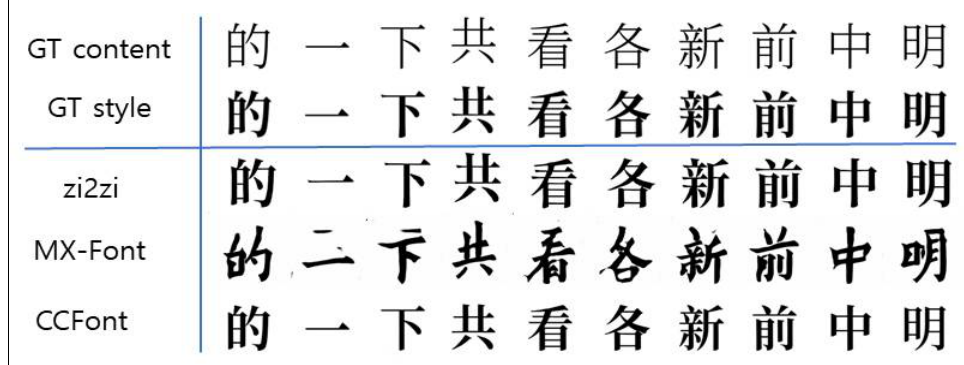
Figure 20. Example outputs by the proposed CCFont and the baselines.